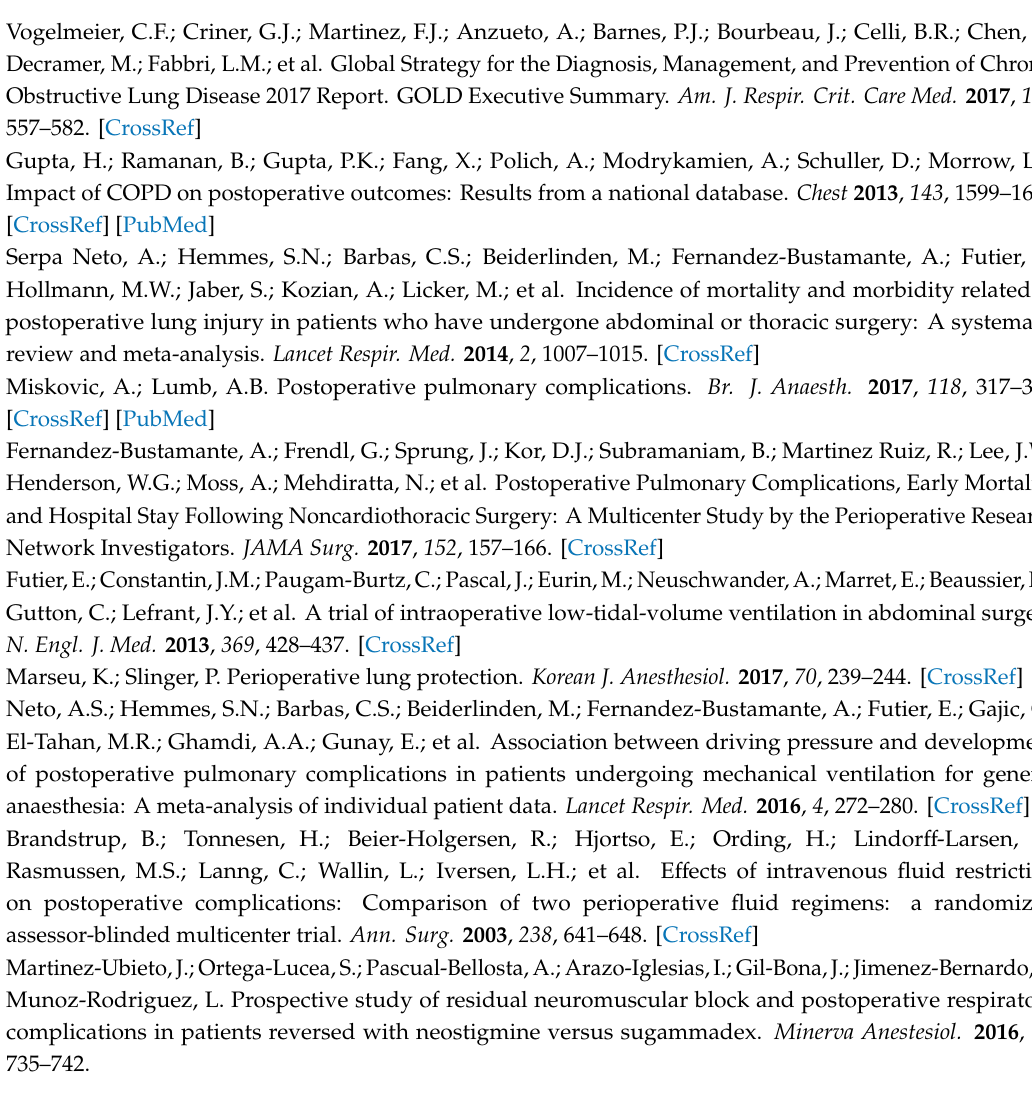
Table S1: Association of tidal volume with each pulmonary complication; Table S2: Association of fluid infusion amount and each pulmonary complication; Table S3: Association of sugammadex use and each pulmonary complication. The English in this document has been checked by at least two professional editors, both native speakers of English. For a certificate, please see supplementary